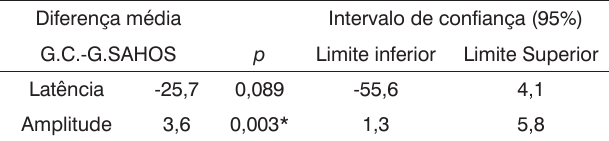
Tabela 2. Prevalência do P 300, segundo a faixa etária, nos G.C e G.SAOS.